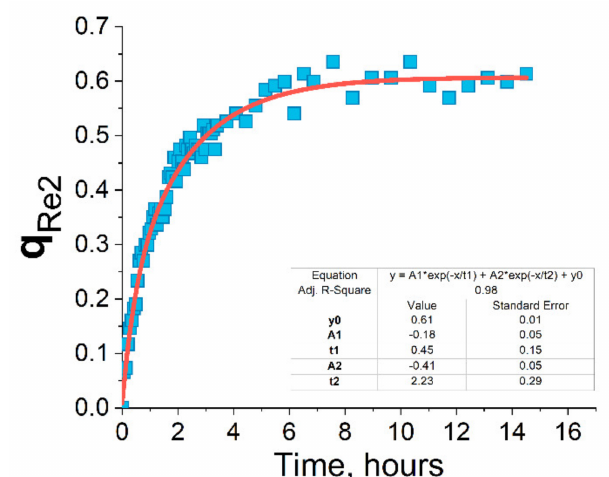
Figure 2. The conversion of Re2 in the copolymerization with p(VP-l) obtained by monitoring of double bond signal disappearance in 1 H NMR spectrum, DMSO-d 6 , 80 ◦ C. IR spectra of the polymeric metal complexes p(VP-l-Re2) – p(VP-l-Re4) and p(VP-h- Re2) – p(VP-h-Re4) , obtained using the Attenuated Total Reflection method, revealed the